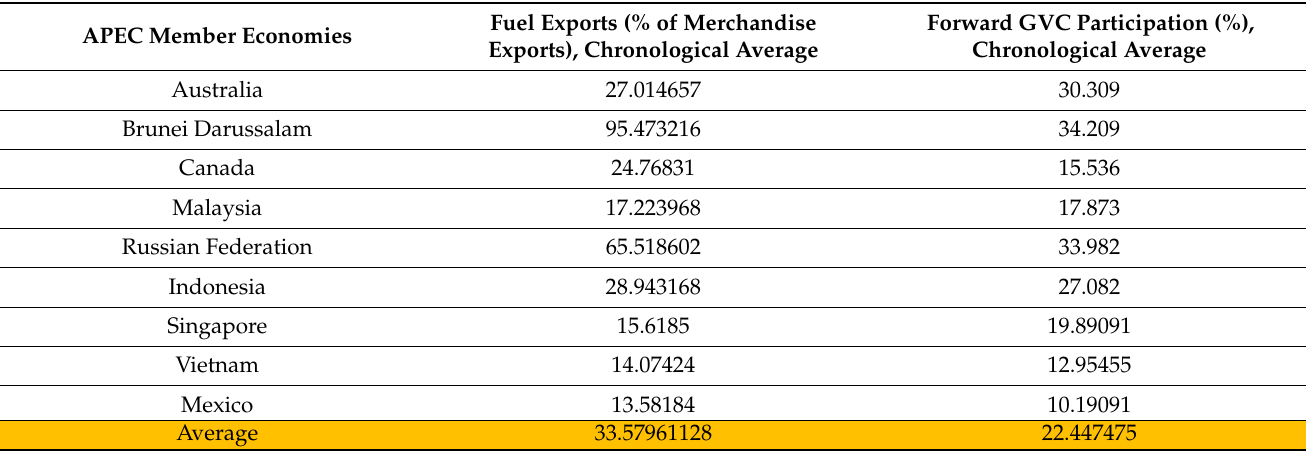
Table 12. APEC member economies—fuel exporters.